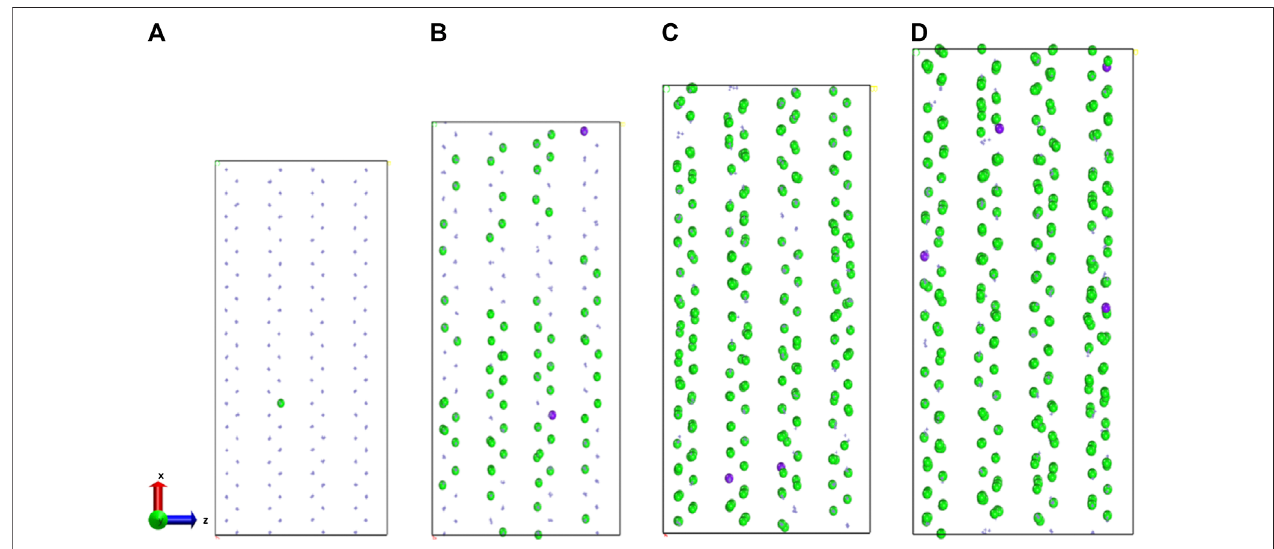
Frontiers in Materials |